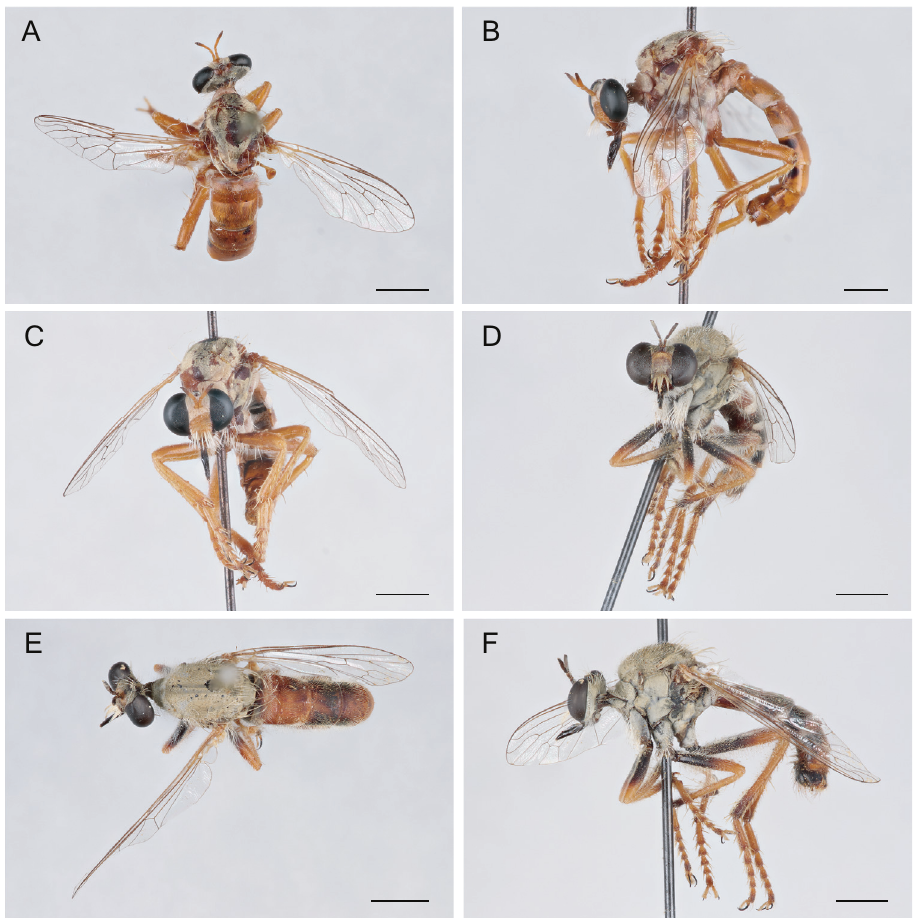
Figure 18. Saropogon mohawki Wilcox, 1966 Female paratype (UCBMEP0003173): A dorsal view B lateral view C anterior view; Male (UCBMEP0003175): D anterior view E dorsal view F lateral view. Scale bars: 2